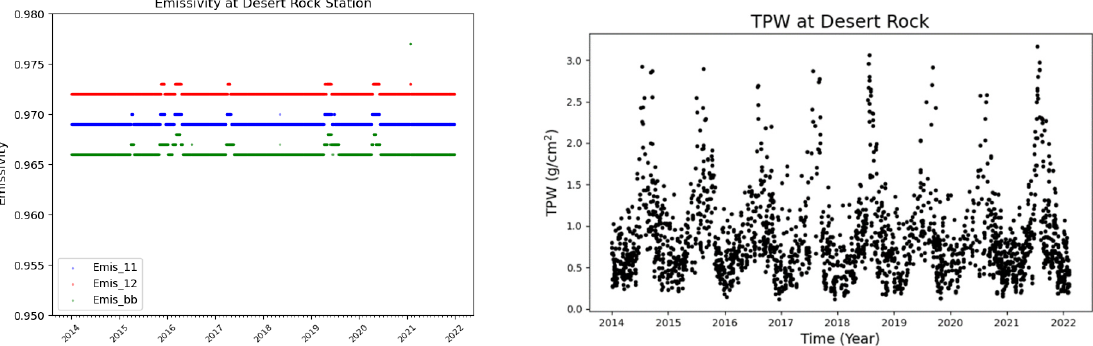
Figure 4. Time series of emissivity including spectral emissivity and broadband emissivity over DRA site ( left ) and TPW obtained from GFS ( right ).